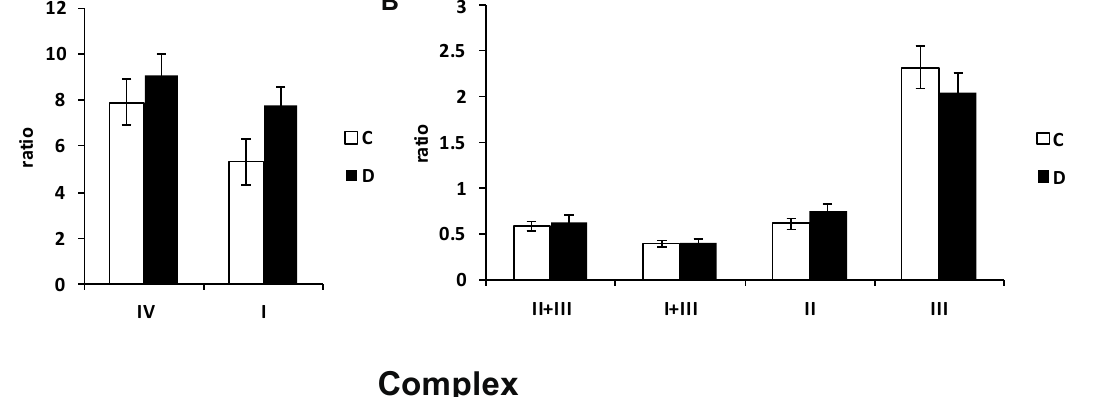
Figure 3. Activities of the respiratory chain complexes in the retinal pigment epithelial cells (RPE) of the minipig eyes after acute high intraocular pressure-induced retinal ischemia. Increased complex I and mildly increased complex IV ( A ) and mildly decreased complex III activity ( B ) were detected in diseased RPE cells in comparison to controls. Activities of the respiratory chain complexes were measured spectrophotometrically in homogenate, normalized values to citrate synthase are shown. I—respiratory chain complex I, NADH: ubiquinone oxidoreductase; II—complex II, succinate: coenzyme Q reductase; III—complex III, ubiquinol: cytochrome c oxidoreductase; IV—complex IV, cytochrome c oxidase; I + III, complex I + III, NADH: cytochrome c reductase; II + III, complex II + III, succinate: cytochrome c reductase. C—control eye, D—eye after acute intraocular pressure elevation. n = 3. Each sample was analyzed in doublets.